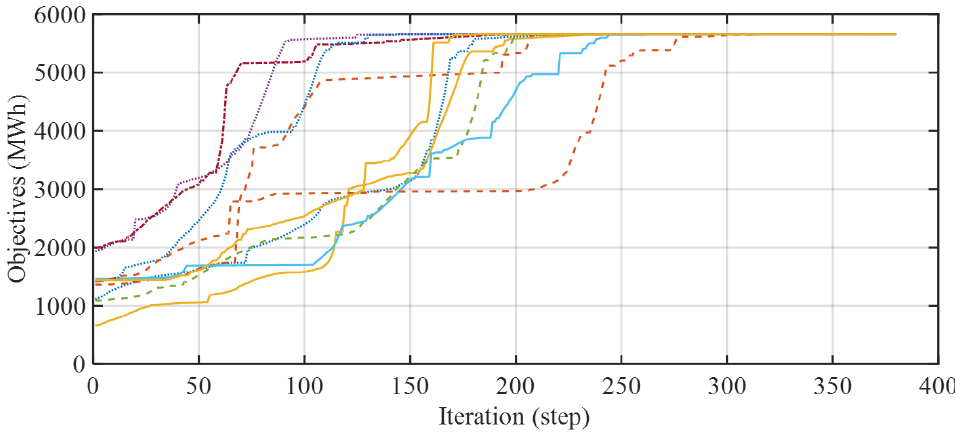
Figure 16. Objectives of convergence test by repeated calculation.